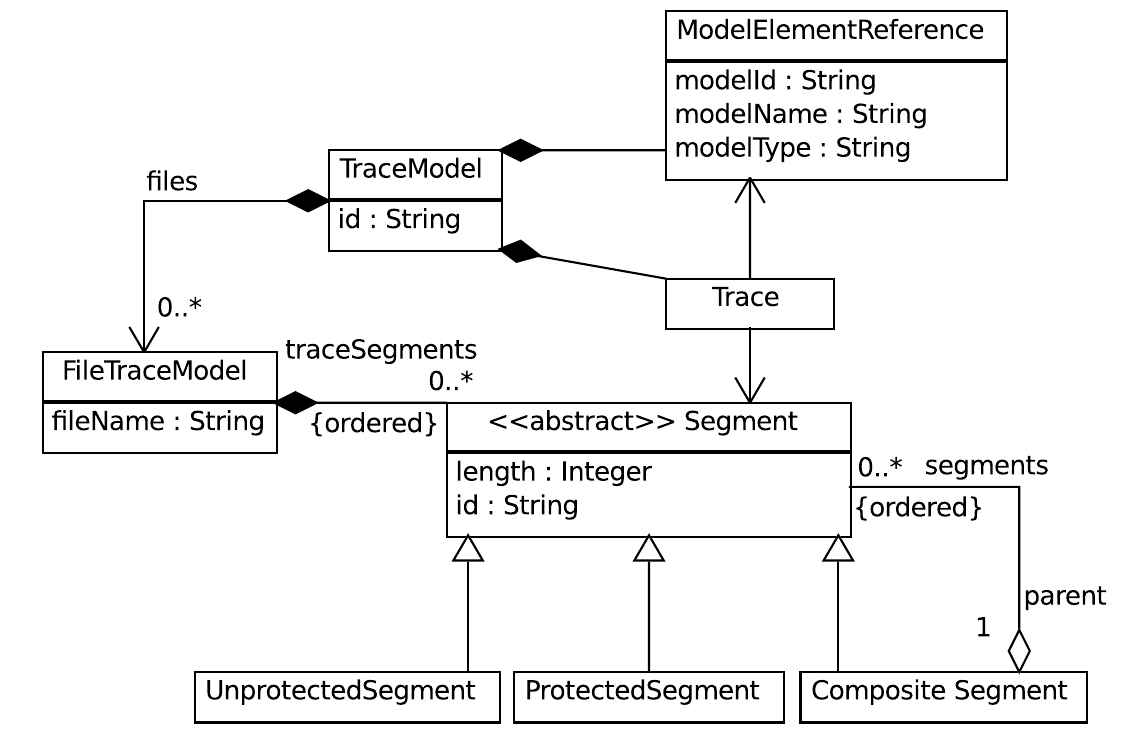
Fig. 9 Trace model used for the live code